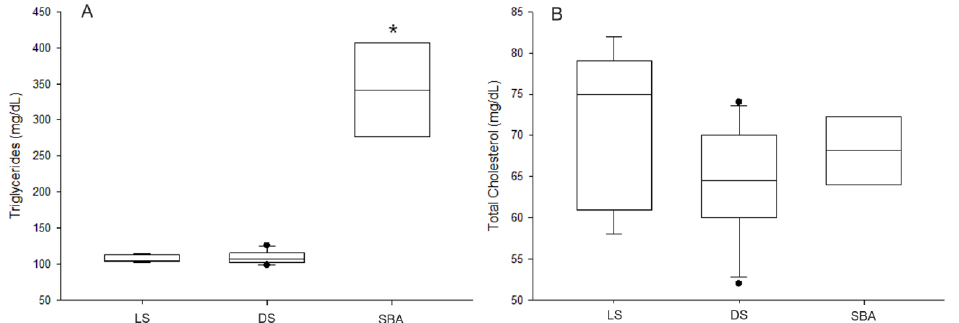
Figure 6. Metabolic markers analyzed in tiger sharks. ( A ) Triglycerides concentrations, ( B ) Total cholesterol concentrations. LS—live sharks, DS—dead sharks, SBA—sharks with bile accumulation. Boxplots respectively represent minimum, first quarter, median, third quarter, and maximum values. Statistical differences are represented by (*).